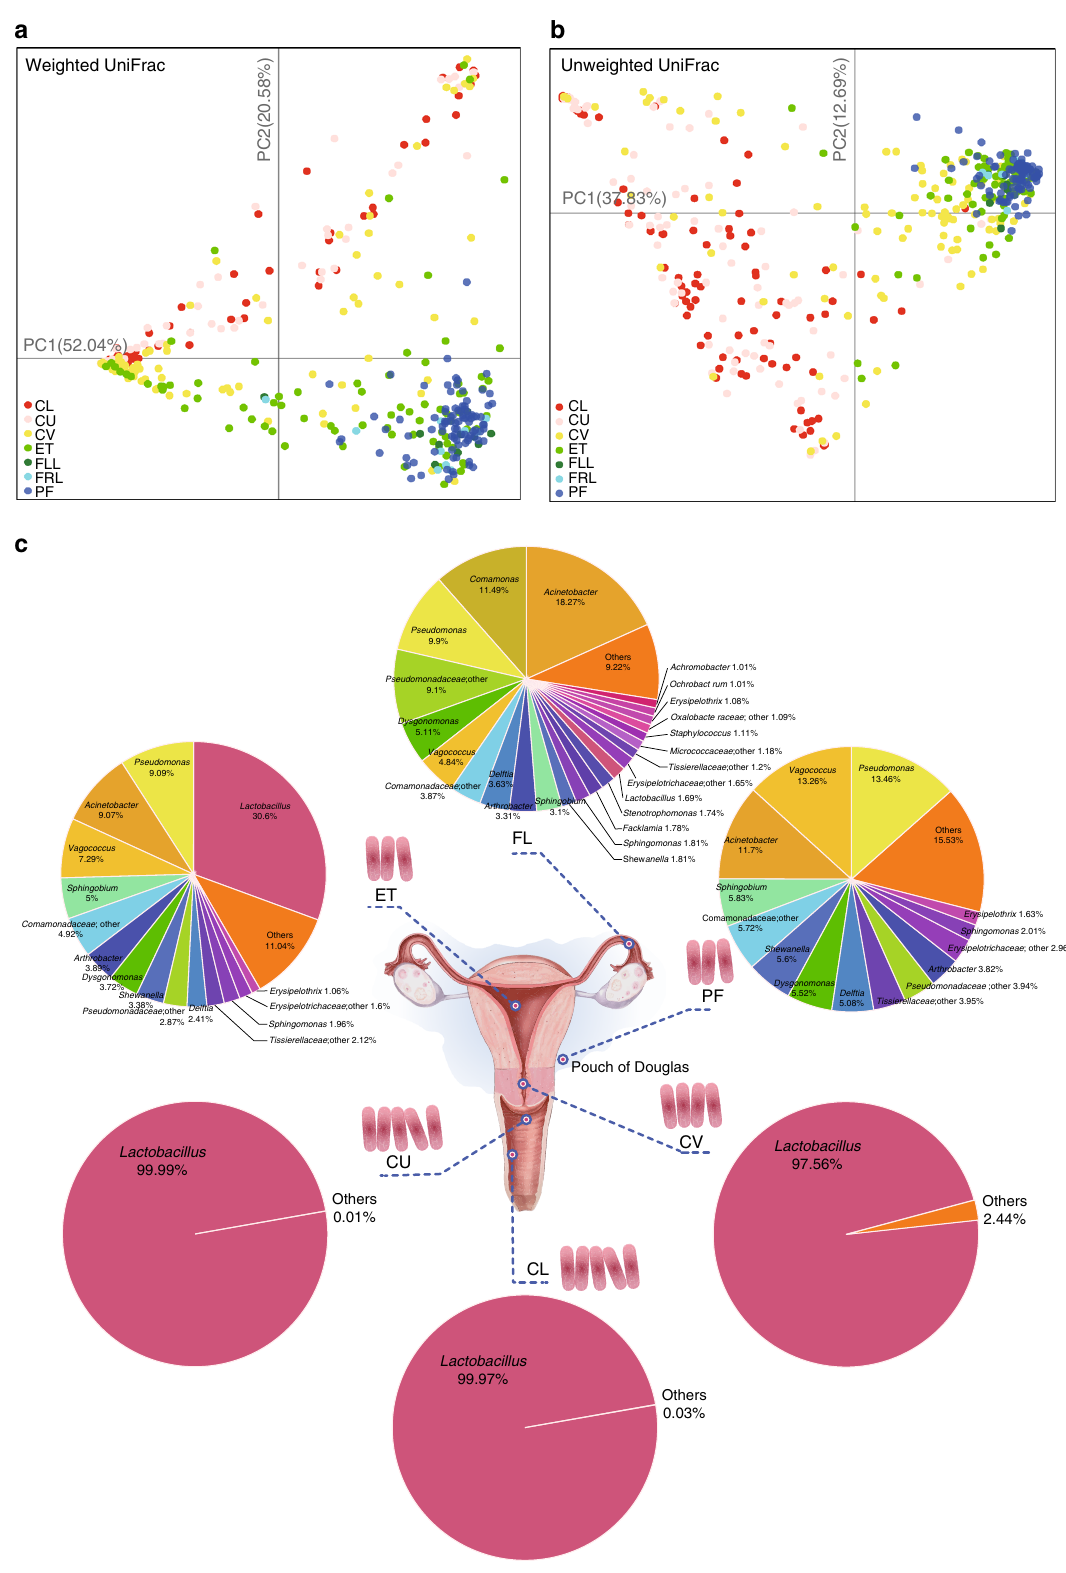
Fig. 1 Composition of the vagino-uterine microbiota. a , b PCoA on the samples based on weighted ( a ) and unweighted ( b ) UniFrac distances. Samples were taken from CL, CU and CV before operation, and from ET, FLL, FRL and PF during operation. Each dot represents one sample. c Pie chart for the microbial genera at each body site according to the median relative abundance. Genera that took up < 1% of the microbiota were labelled together as ‘ others ’ . A pink rod represents about 10 2 copies/sample, according to the qPCR results in Supplementary Fig. 5e. Samples derive from the study cohort of 95 reproductive-age women ( n = 94 CL, 95 CU, 95 CV, 80 ET, 93 PF, 9 FLL and 10 FRL, Supplementary Data